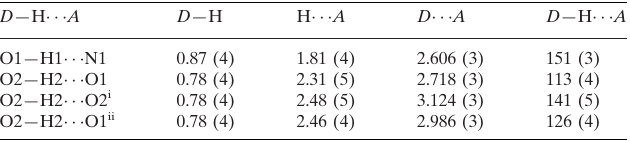
Hydrogen-bond geometry (A˚ , (cid:2) ).